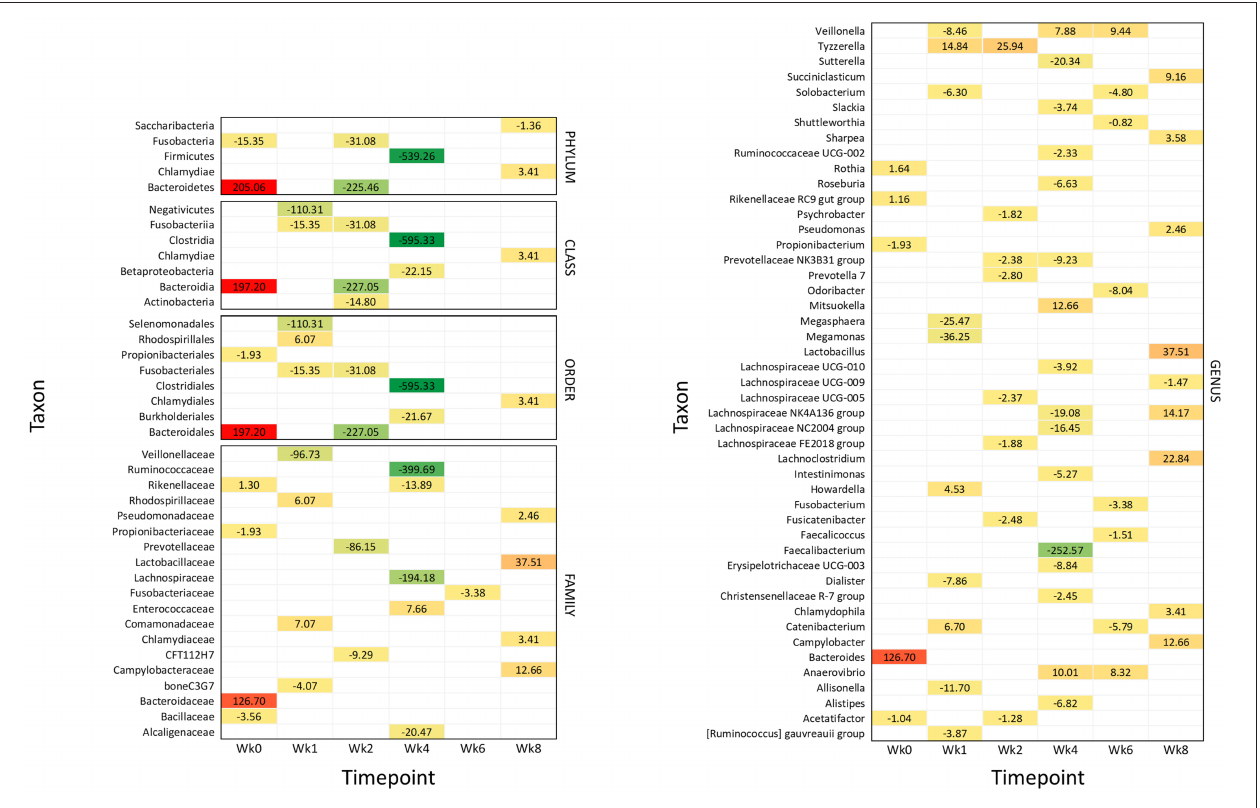
FIGURE 4 | Significantly different taxonomic groups in the fecal microbiota in the two calf groups at the different time points. The results are reported as a heatmap where red indicates a decrease and green indicates an increase of the normalized operational taxonomic unit (OTU) value in waste milk (WM) calves vs. bulk milk (BM) calves for each taxon at the different time points. The normalized OTU values and the statistical significance of the differences are reported in Supplementary Figures 2 , 3 ,